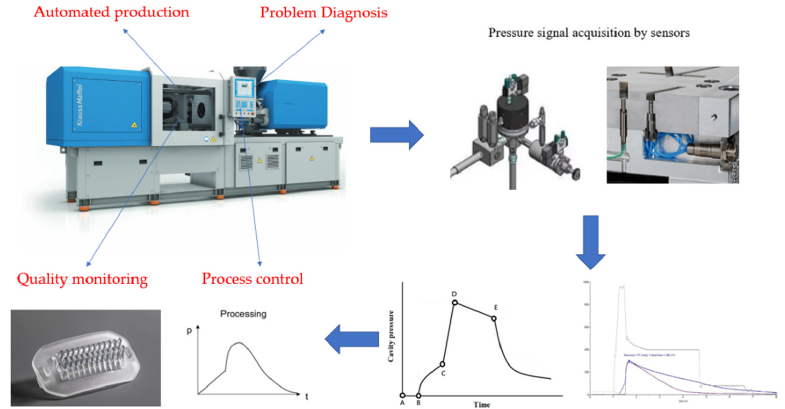
Figure 1. Application of pressure sensors in injection molding machines.